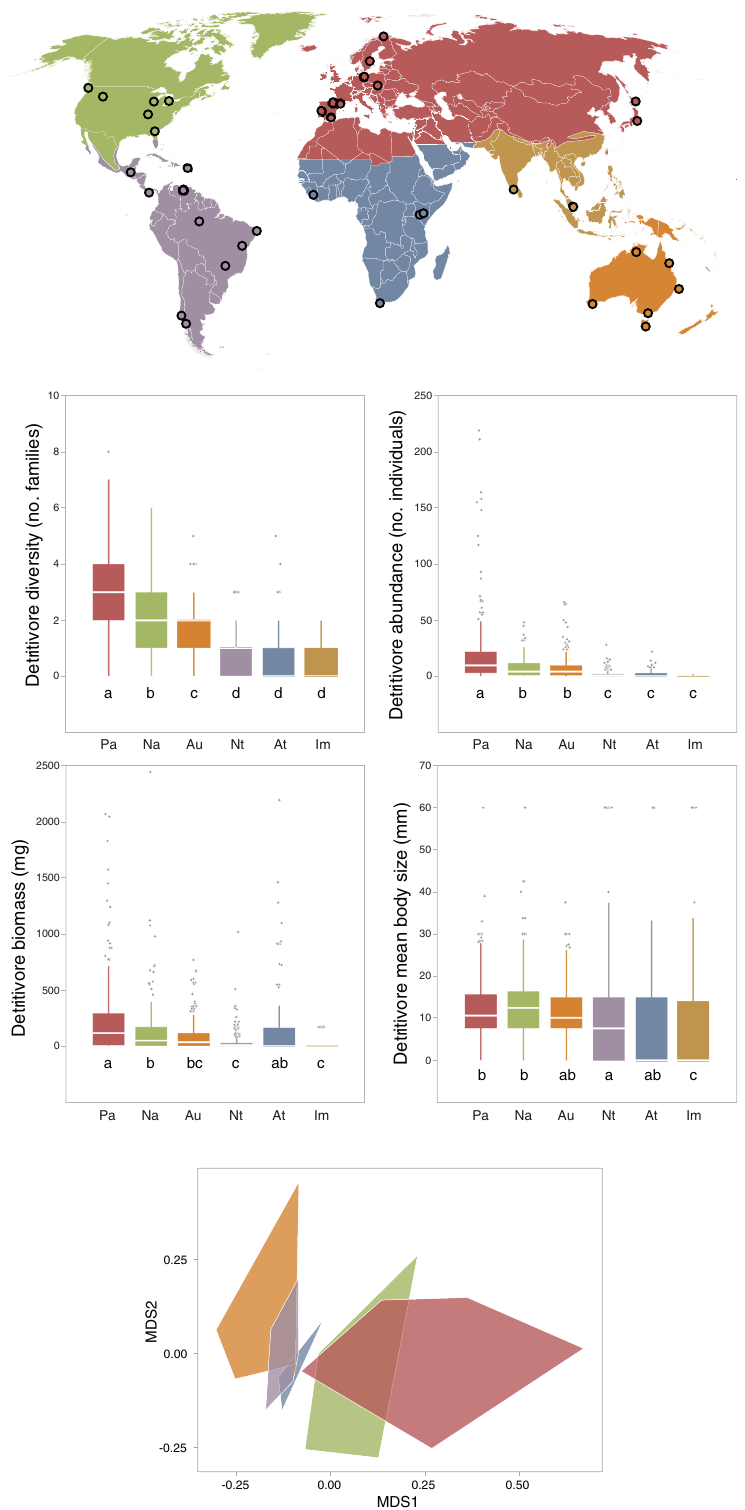
Fig. 2 Global distribution of study sites in different biogeographic realms (Pa, Palearctic; Na, Nearctic; Au, Australasian; Nt, Neotropical; At, Afrotropical; Im, Indomalayan); n = 38. Box plots show the median, interquartile range and minimum-maximum range of litter-consuming detritivore diversity (number of families per litterbag), abundance (number of individuals per litterbag), biomass (mg per litterbag) and mean body size (mm) in each realm (ordered from highest to lowest diversity); different letters indicate signi fi cant differences. The NMDS ordination of litter-consuming detritivores with realms is represented by polygons of different colours as in maps and box plots. Signi fi cant differences in assemblage structure were: Pa vs. Na, At, Au, Im; Na vs. Nt, Au; Nt vs.